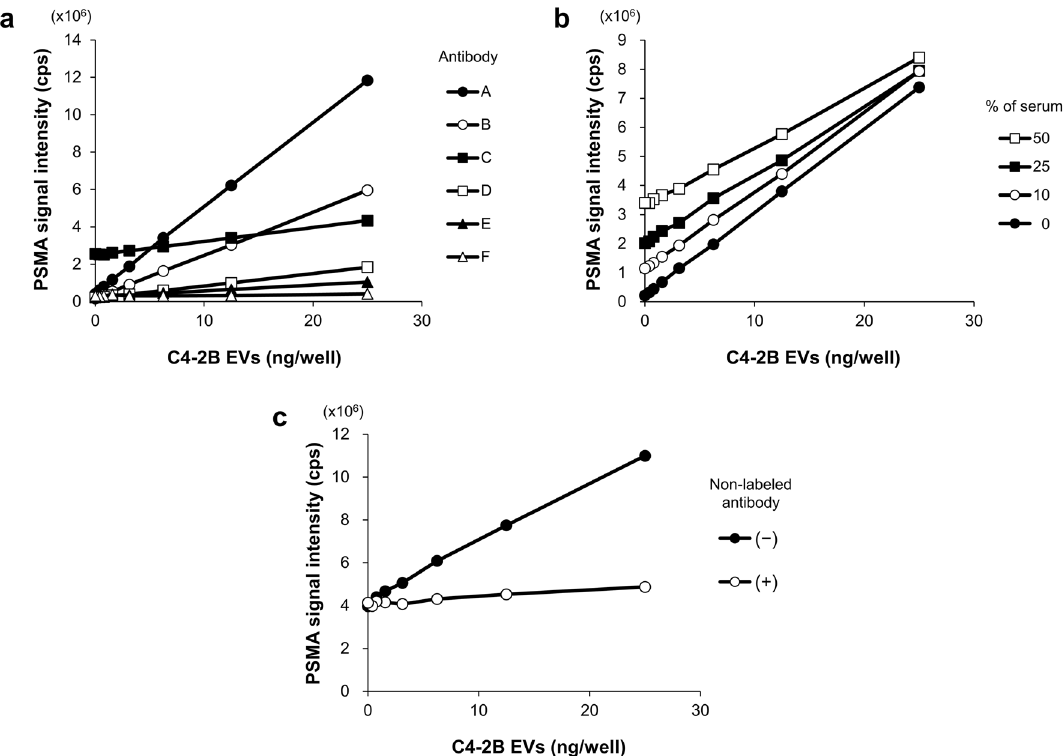
Figure 2. Determination of the optimal conditions for the plate-based PSMA-EV sandwich ELISA. EVs isolated by sequential centrifugation from culture medium of C4-2B cells (C4-2B EVs) were used as a